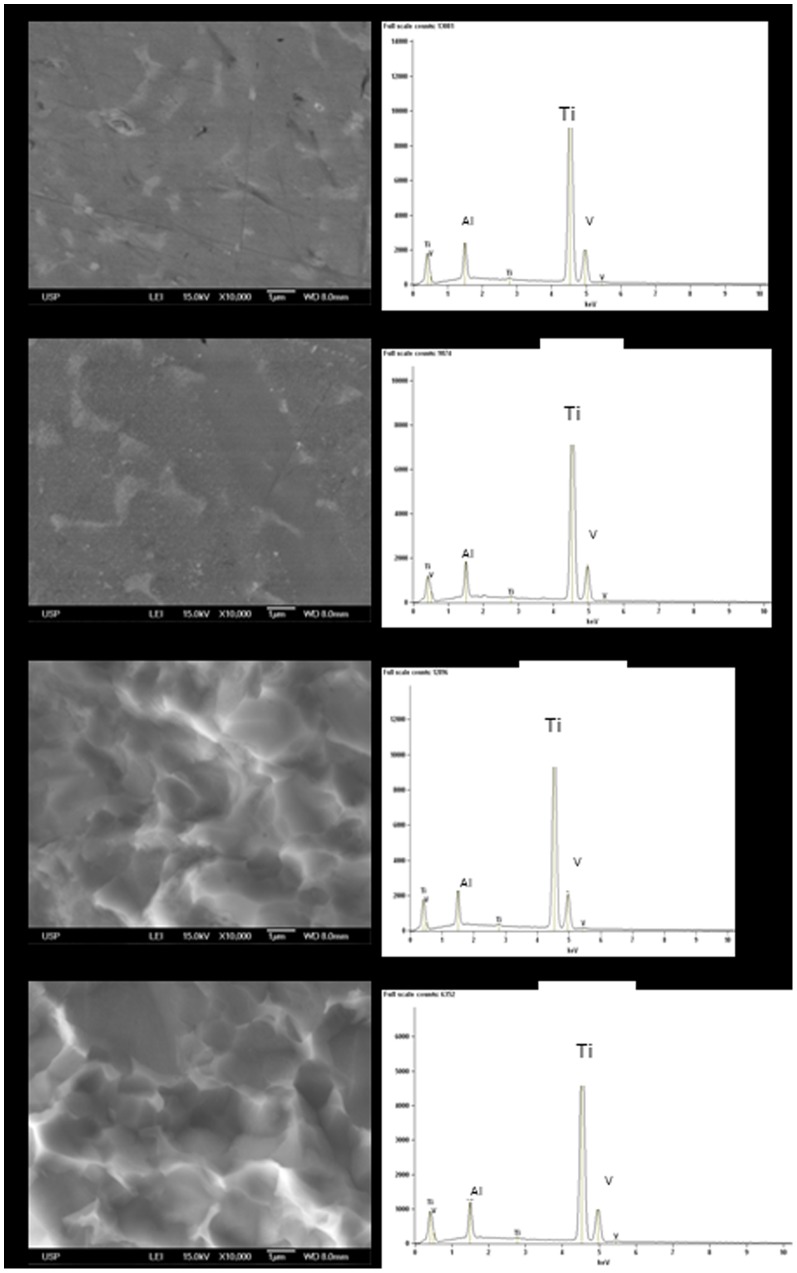
Representative energy-dispersive spectroscopy (EDS).(a) Ti-6Al-4V alloy with smooth surface before corrosion test. (b) Ti-6Al-4V alloy with smooth surface after the corrosion test. (c) Ti-6Al-4V with acid-etched surface before the corrosion test. (d) Ti-6Al-4V with acid-etched surface after the corrosion test.